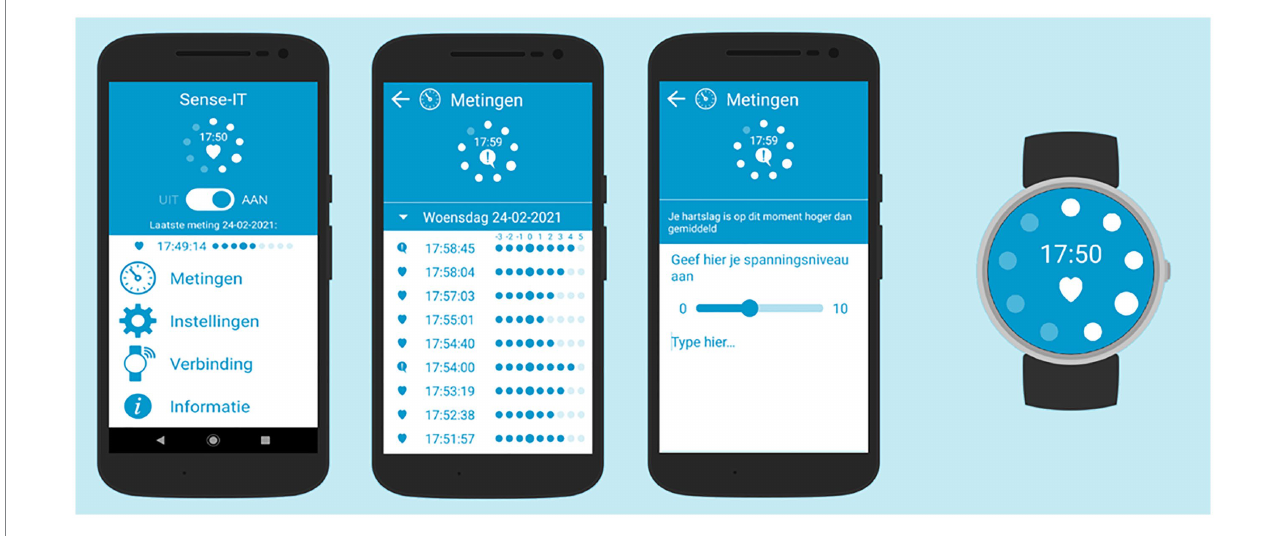
FIGURE 2 Screenshots of the Sense-IT app (version 2.57) with the main screen (presenting four menus: measurements, settings, connectivity, and information), measurement screen (presenting HR levels), notes screen (presenting default message, question to rate subjective level of arousal, and space for personal notes) and one of the watch